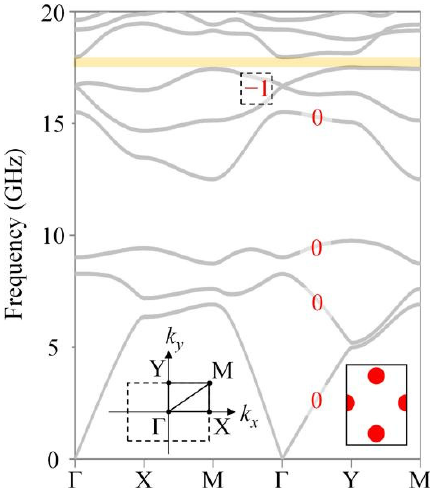
Figure 2. Bulk band of a square-hexagon lattice GPC. There existed a complete bandgap ranging from 17.45 to 17.95 GHz (yellow region) and the Chern number of each band below the second bandgap is marked (red). The Chern number of the first, second, third and fourth bands was zero, while the total Chen number of the intersecting fifth and sixth bands was − 1. The lower left inset is the first Brillouin zone of a square-hexagonal lattice. The lower right inset is the unit cell of square-hexagon